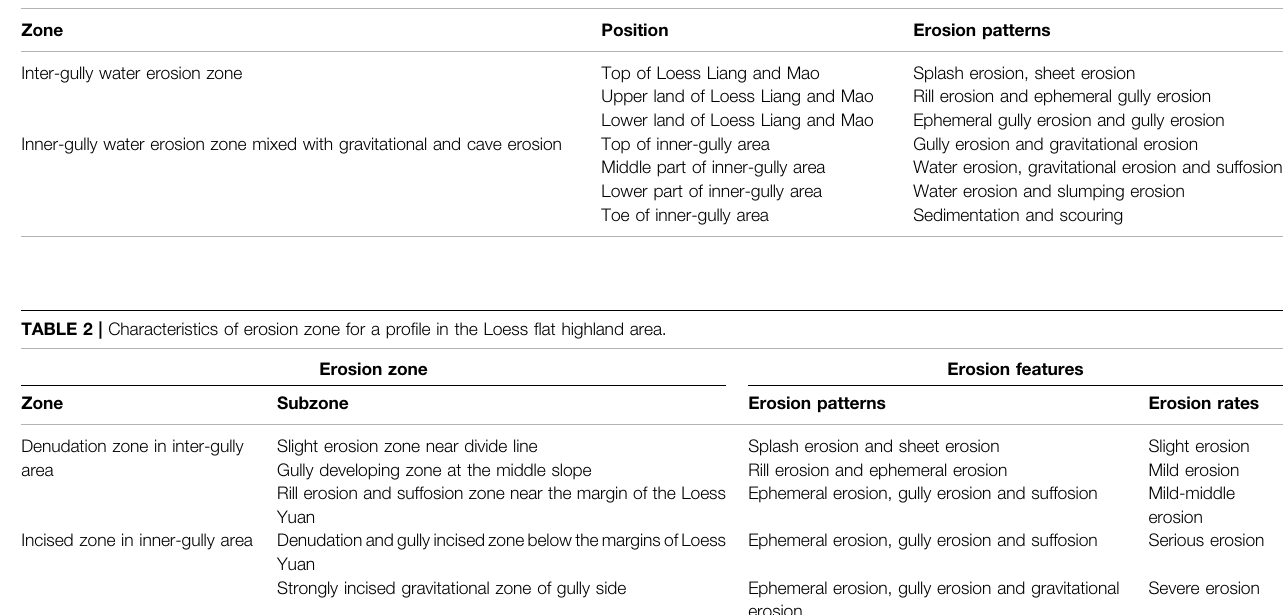
TABLE 1 | Vertical zones of erosion processes in a small catchment of the Loess gullied hilly area.